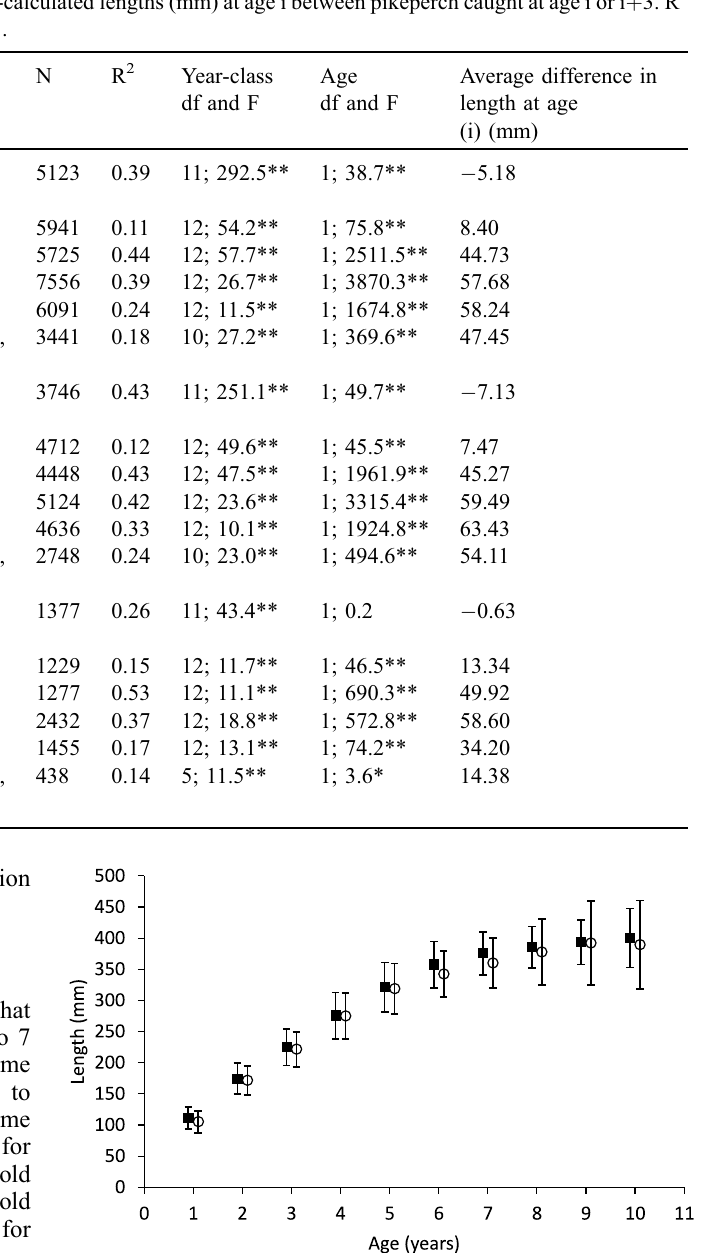
Fig. 4. Back-calculated lengths (± 1 SD) of pikeperch in gillnets (black squares) and in trap nets (open circles). Markers are shifted ( – 0.1 years for gillnets and þ 0.1 for trap nets) for